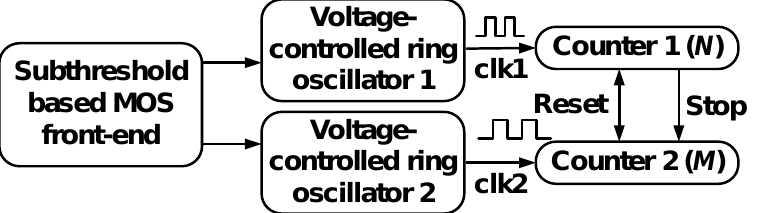
Figure 17. The inaccuracy (IA) versus the temperature range. The reference numbers are labelled close to the markers of the type II sensors. For instance, [Zhao, 2014, two] means the reference ‘s author is ‘Zhao’, and it is published in 2014, and its inaccuracy is obtained after a two-point trim- ming.